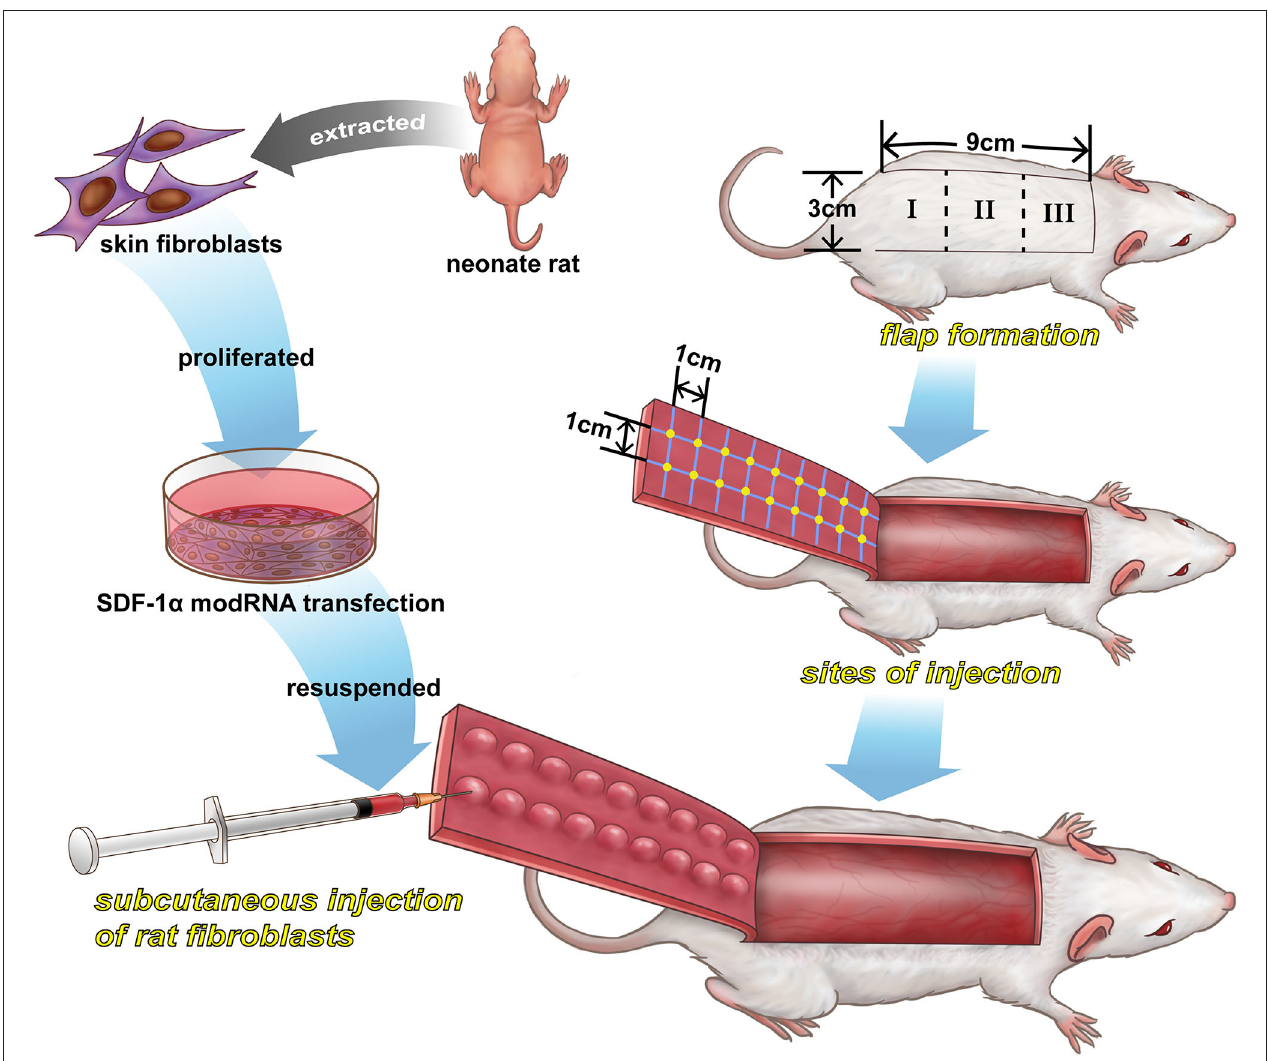
FIGURE 1 | A schematic illustration of the preparation of SDF-1 α modRNA-transfected in fibroblasts and the design of the in vivo experiments.